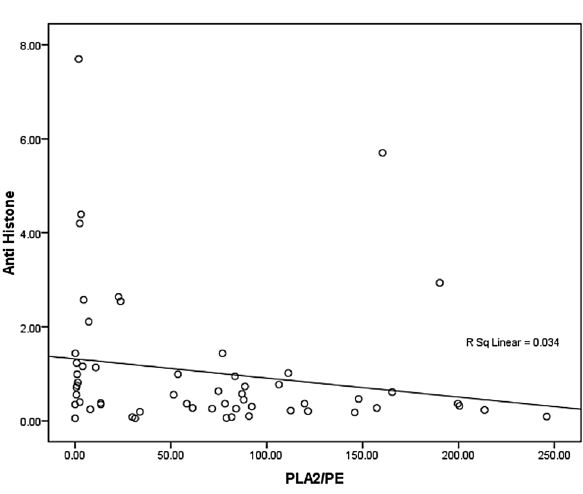
Figure 3. Correlation between PLA2/PE and anti histone with best fit line curve (negative correlation).